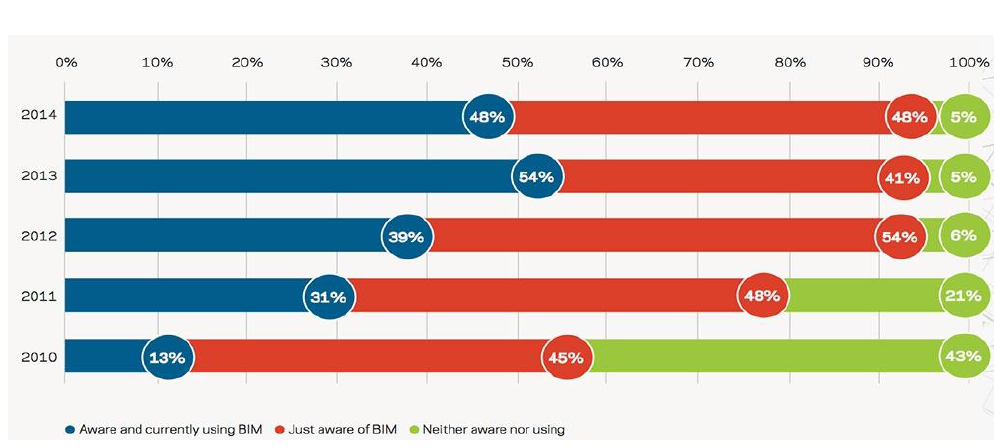
Fig. 3. BIM awareness and usage, data representation of BIM awareness in the UK (National BIM Report,